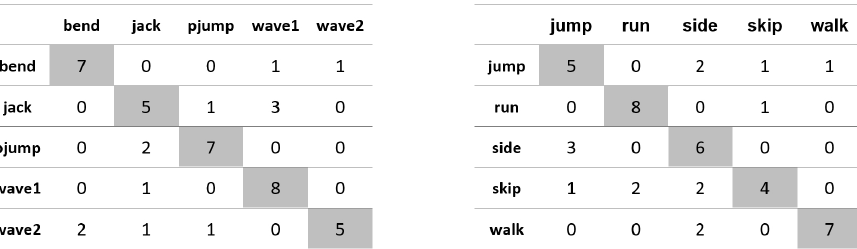
Figure A15. Confusion matrices for the experiment using the ‘lower-occlusion’ database, MBR area and C1 correlation.